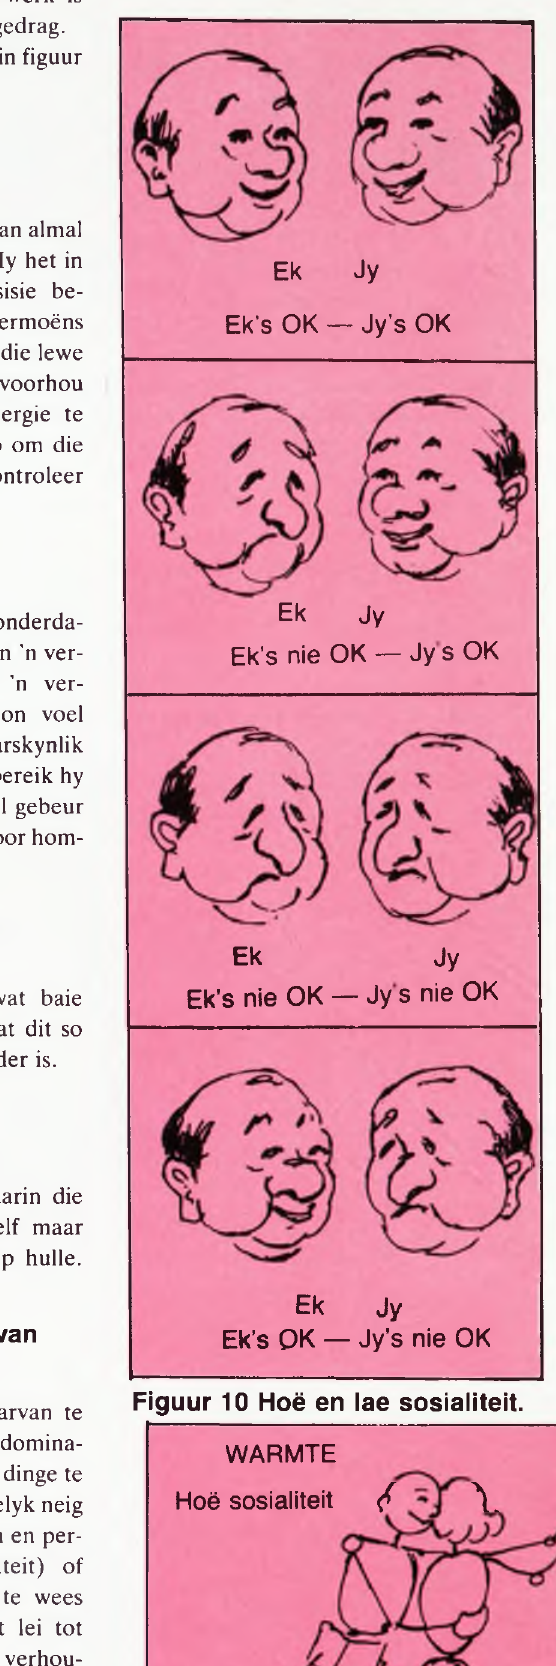
Figuur 10 Hoë en lae